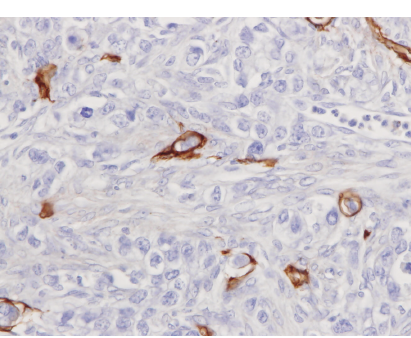
Figure 1: Immunohistochemical expression of D2-40 in metastatic ovarian tumor originating from gastric cancer. Immunohistochem- ical analysis revealed the tumor to be immunoreactive for D2-40. Positive portions (brown) show lymphatic endothelium. We found the cancer cells in the lymphatic vessels. It means positivity for lym- phangio